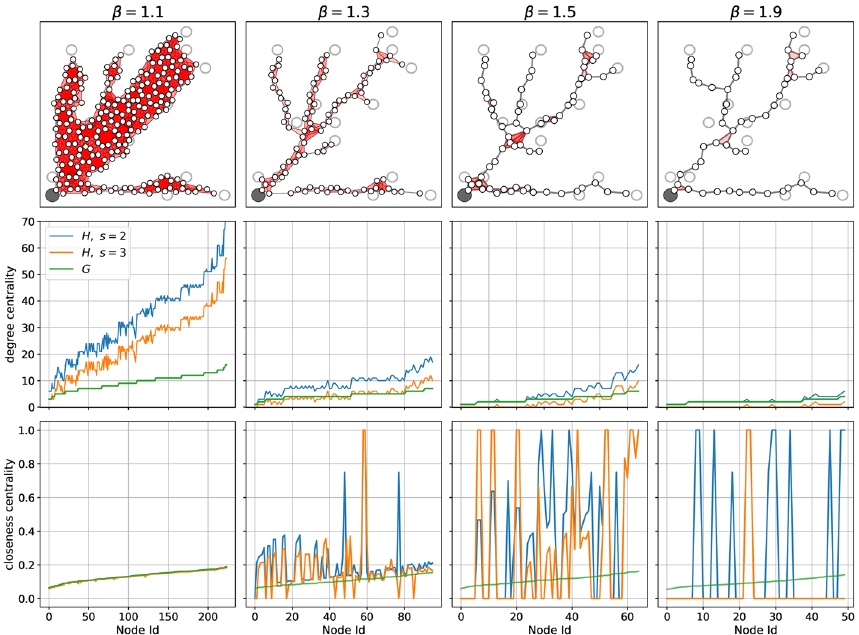
Fig. 4 Graph and Hypergraph properties. Top row: optimal hypernetworks obtained with different traffic rates. Center and bottom rows: degree distributions and closeness distributions for the hypernetworks shown on the top row, and their 1-skeletons. The node labels in the x -axis of the center and bottom rows are sorted by their degree of centrality